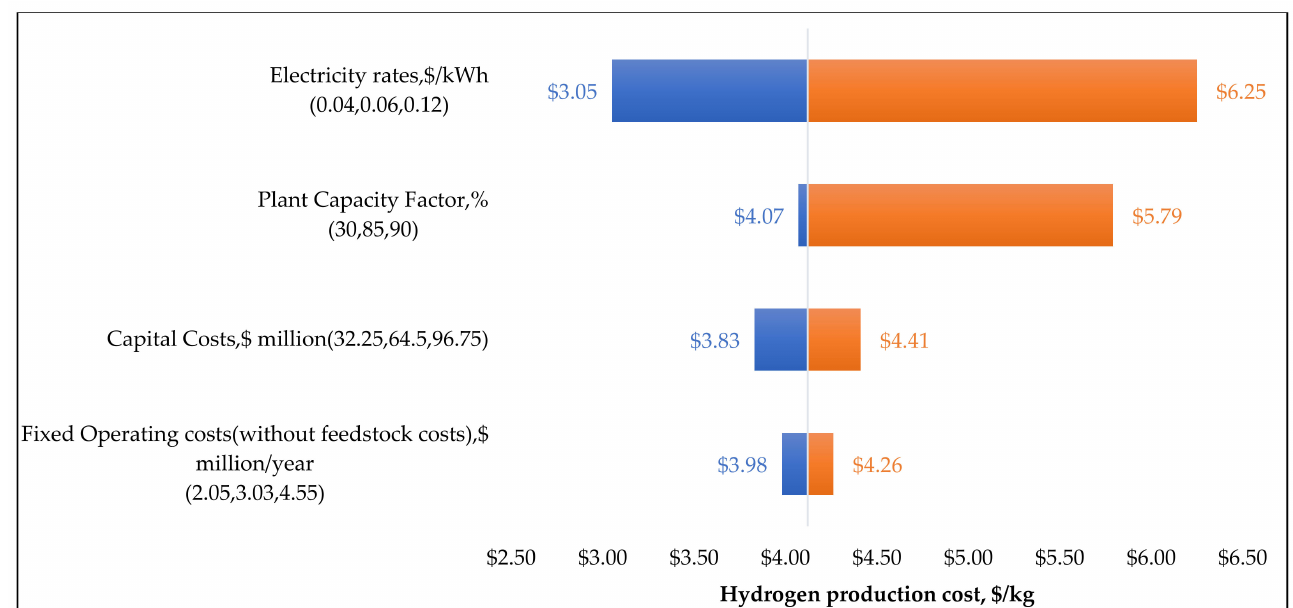
Figure 9. Range of hydrogen production costs for a 30 tpd central PEM electrolysis plant.